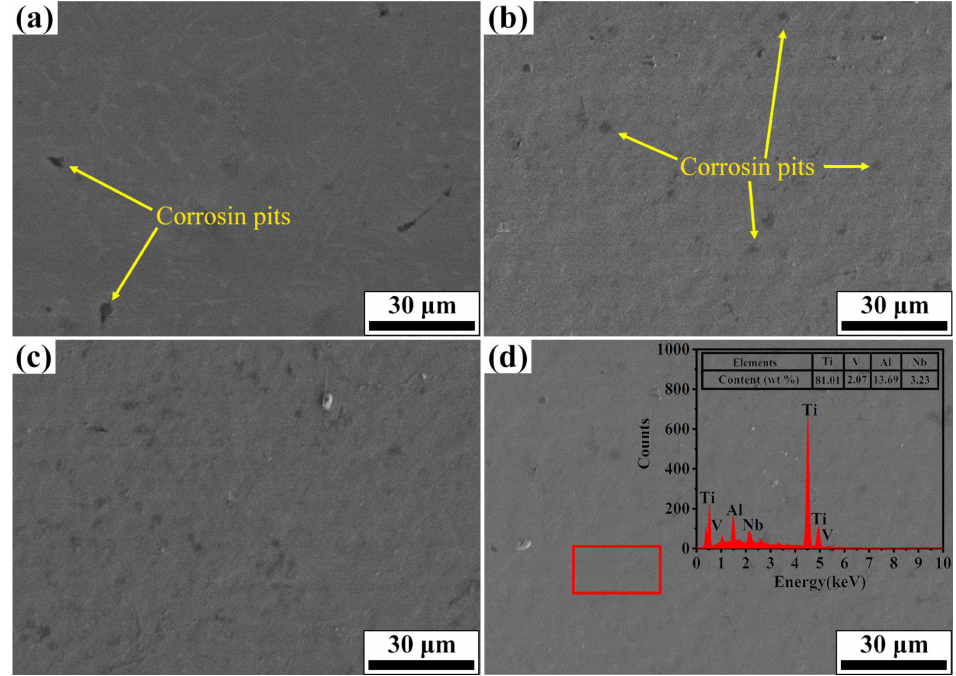
Figure 10. Corrosion morphology and EDS analysis of initial and Nb-alloyed samples. ( a ) Initial; ( b ) 20 pulses; ( c ) 30 pulses; ( d ) 40